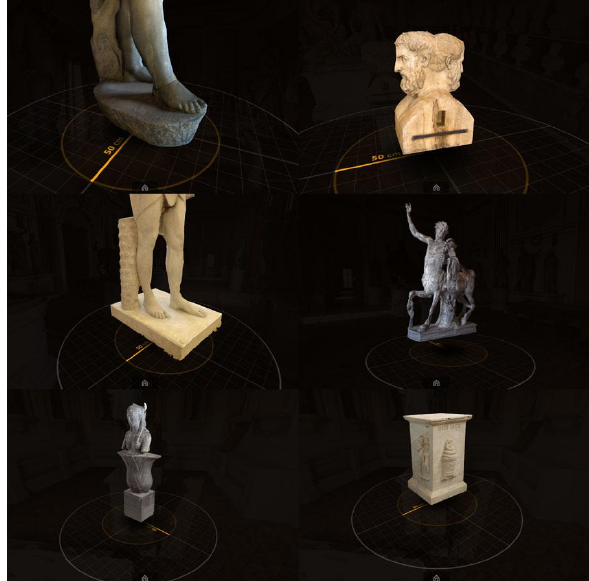
Figure 12. 3D viewer and inspection of a few items on mobile devices with reference